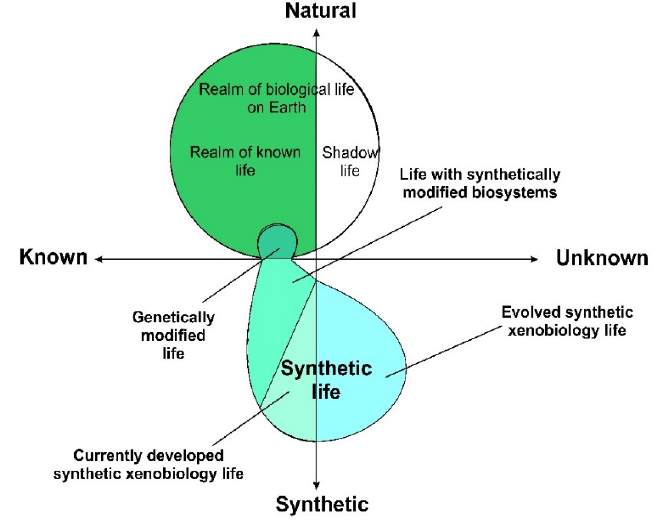
Figure 5 . Natural life and emergence of synthetic